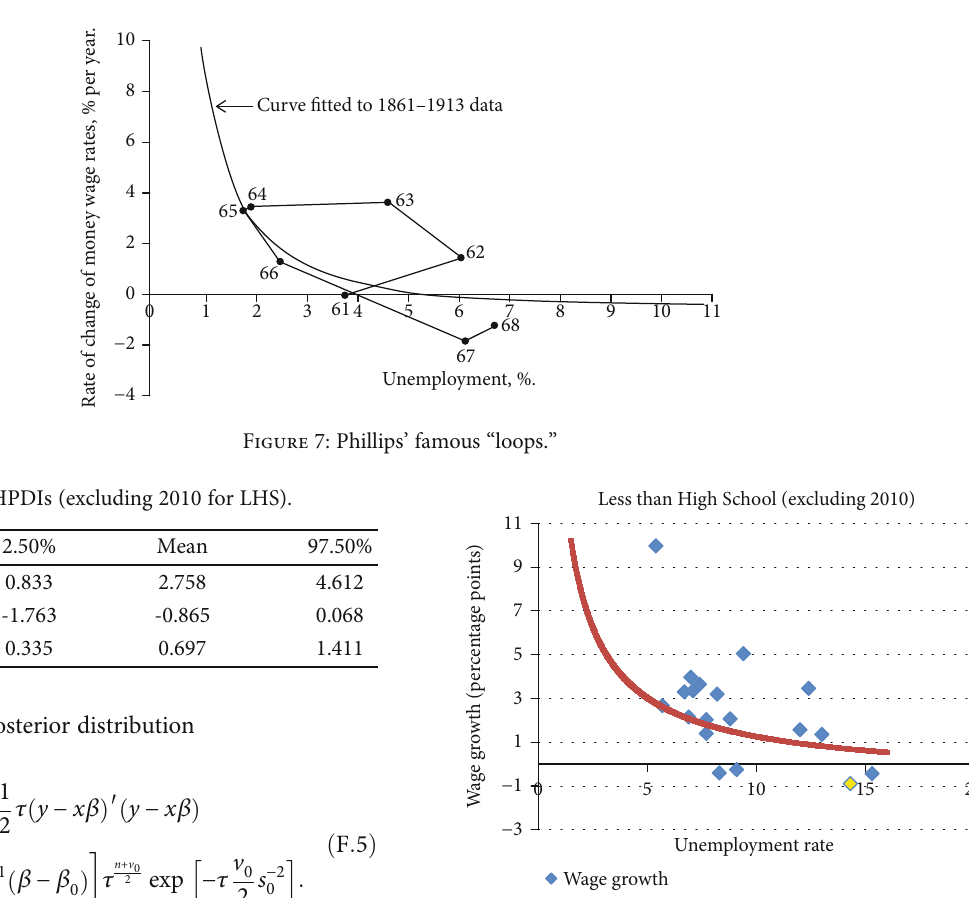
Figure 6: NAIRU theory graphical representation (this chart comes from Dritsaki and Dritsaki [13]).